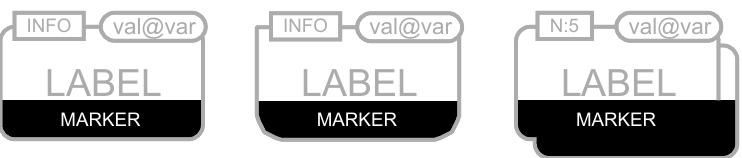
Figure 2.7: The Process Description glyph for labelled clone marker applied to a macro- molecule , a nucleic acid feature and a multimer of macromolecules